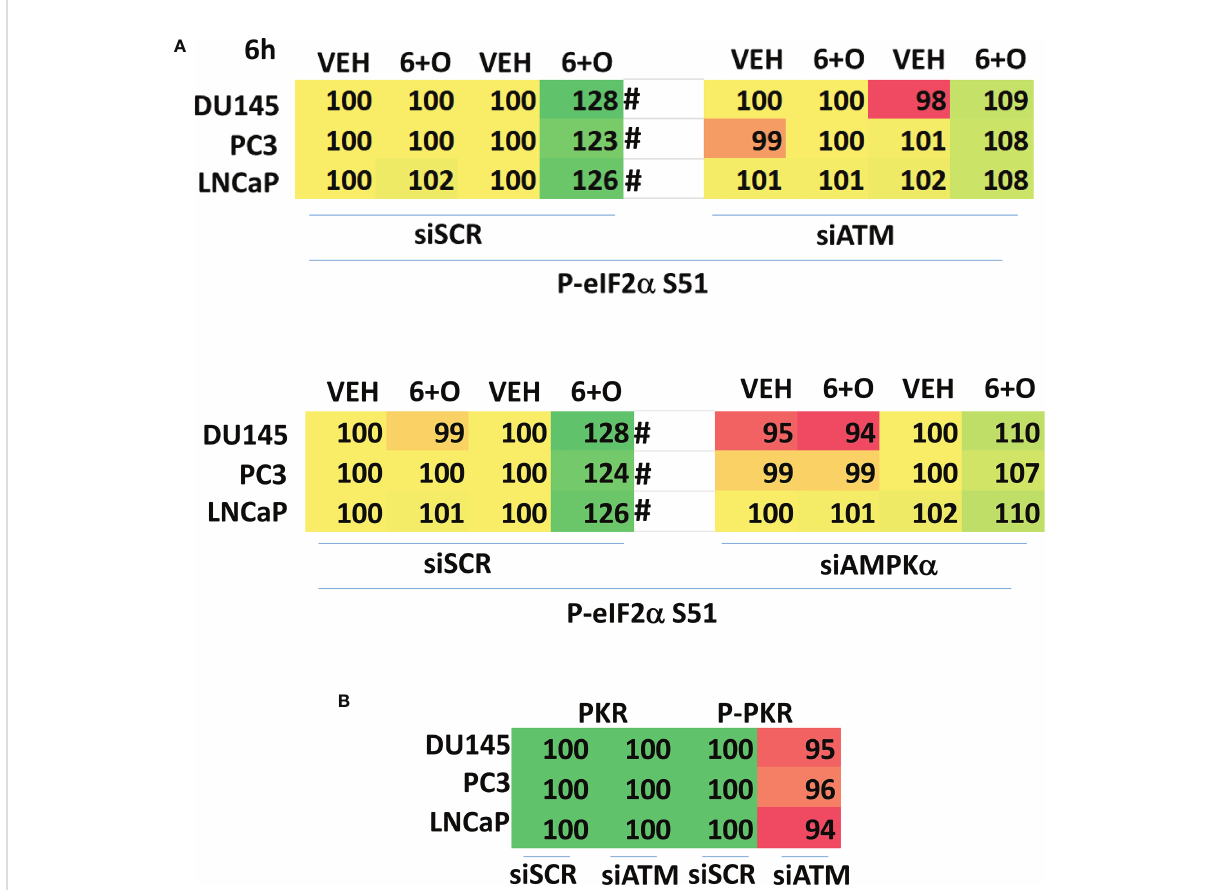
FIGURE 10 Knock down of ATM or AMPK a reduces the ability of [GZ17-6.02 + olaparib] to increase eIF2 a S51 phosphorylation. (A) Cells were transfected with a scrambled siRNA control or with siRNA molecules to knock down the expression of either ATM or AMPK a . After 24h, cells were treated with vehicle control or with [GZ17-6.02 (2 m M) and olaparib (50 nM)] in combination for 6h. Cells were fi xed in situ, permeabilized, stained with the indicated validated primary antibodies and imaged with secondary antibodies carrying red- and green- fl uorescent tags. The staining intensity of at least 100 cells per well/condition is determined in three separate studies. The data are the normalized amount of fl uorescence set at 100% comparing intensity values for vehicle control (n = 3 +/-SD). #p < 0.05 greater than vehicle control; *p < 0.05 less than vehicle control. (B) Cells were transfected with a scrambled siRNA control or with siRNA molecules to knock down the expression of ATM or AMPK a . After 24h, cells were fi xed in place and staining for PKR and ERK2 as a loading control performed (n = 3 +/-SD) * p < 0.05 less than siSCR